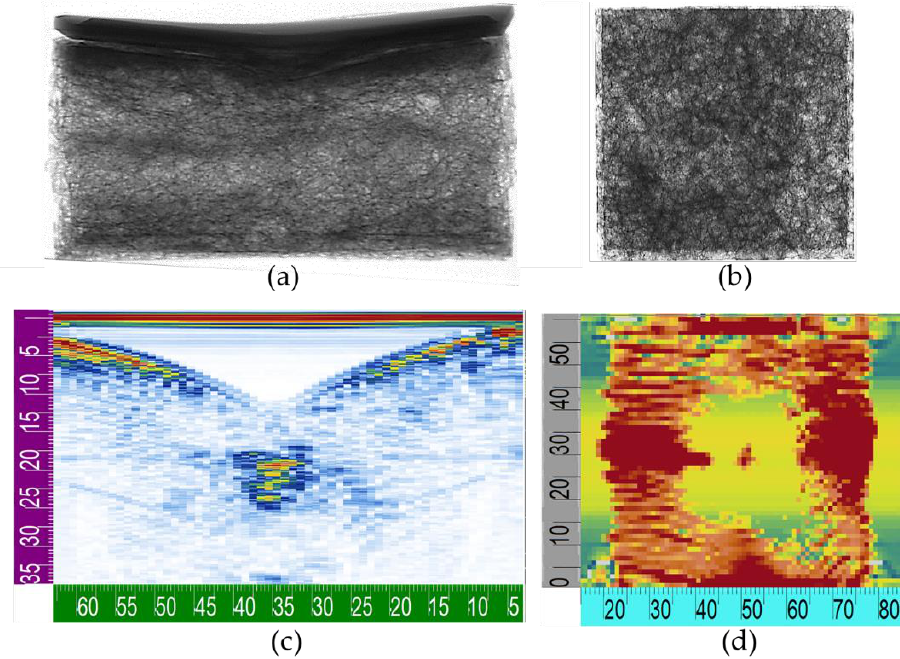
Figure 13. ( a , b ) Radiographic and ( c , d ) UPA inspections for Type IV specimen subjected to a second impact of 35 J.